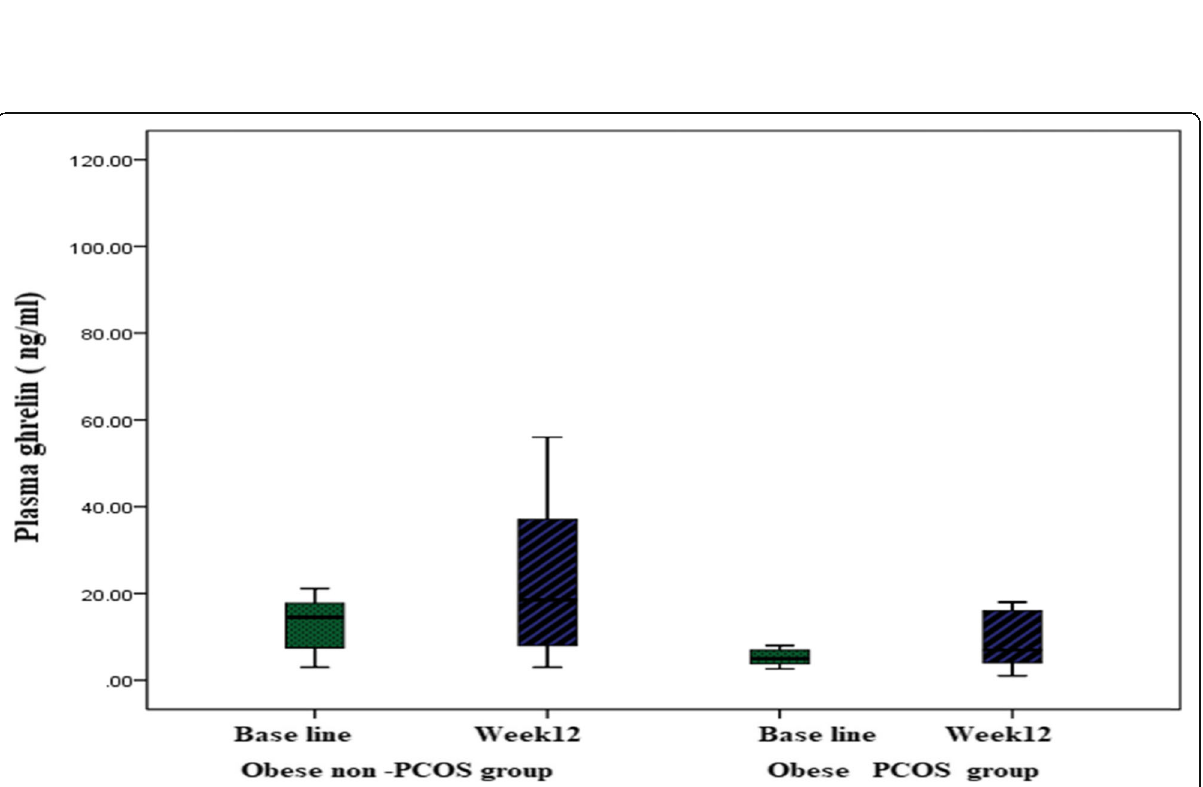
Fig. 2 Impact of weight loss on plasma ghrelin (ng/ml) level in obese